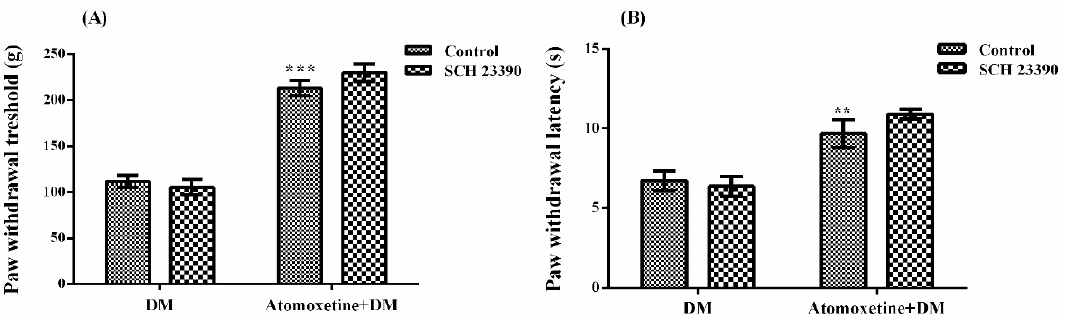
Figure 6. Effects of SCH 23390 pre-treatments on the antihyperalgesic responses induced by atomoxetine (3 mg/kg, 14 days) against mechanical ( A ) and thermal ( B ) nociceptive stimuli applied in the Randall-Selitto and Hargreaves tests, respectively. Values are given as mean ± S.E.M. Significant difference against physiological saline administrated diabetic group (DM) is ** p < 0.01; *** p < 0.001. Two-way repeated ANOVA, post hoc Bonferroni test, n = 8.